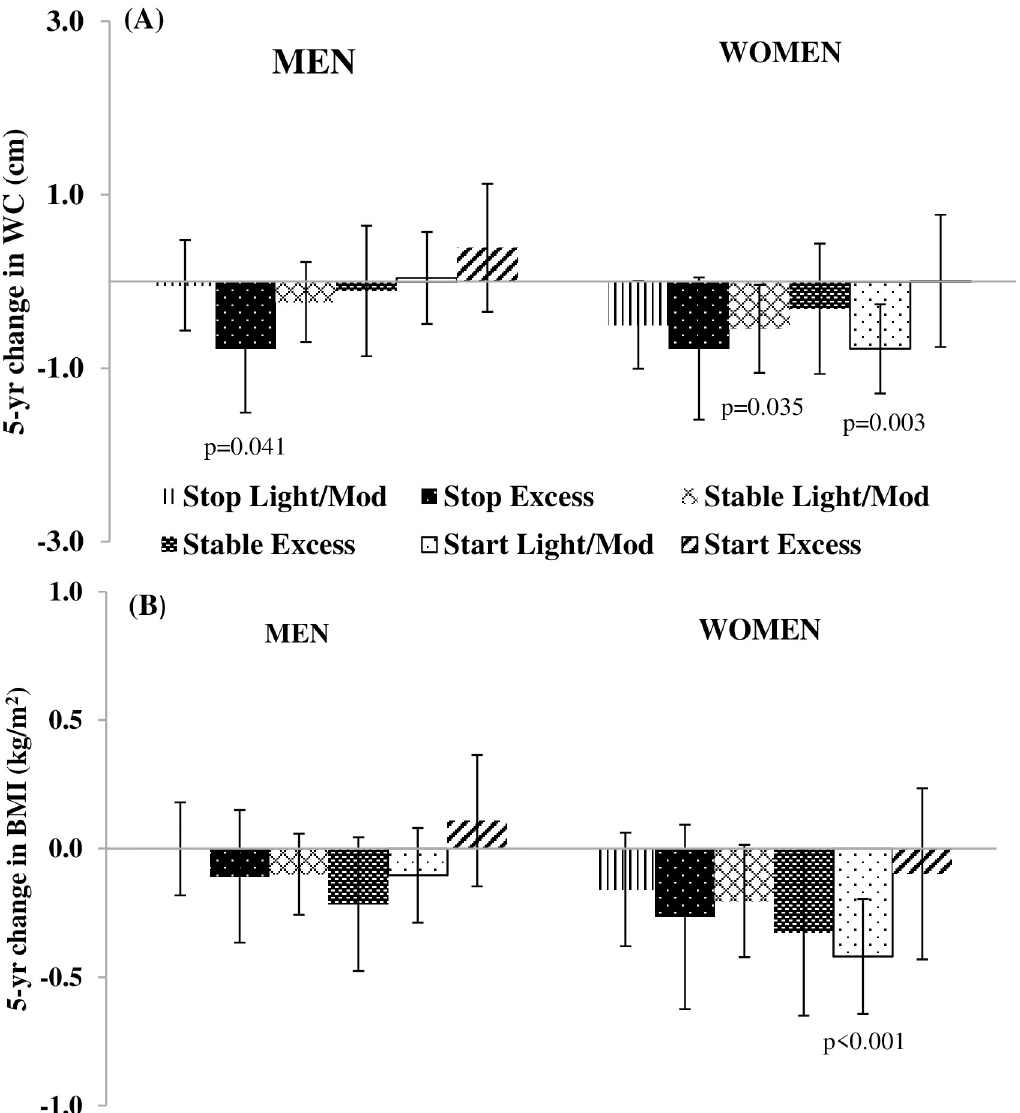
Fig 3. Adjusted associations of 5-yr changes in drinking level with 5-yr changes in (A) Waist Circumference (WC) (cm) and (B) Body Mass Index (BMI) (kg/m 2 ) for men and women in the CARDIA Study from 1985–1986 to 2010–2011. Data from men (N = 1,974) and women (N = 2,381) for 5-yr changes in (A) WC and (B) BMI from CARDIA exam yrs 5, 10, 15, 20 and 25. Values are β coefficients (95% CI) obtained from longitudinal random effects linear regression models adjusted for baseline age cohort membership, baseline WC, race and study center and time-varying income, education, smoking status and time-varying changes in marital status, physical activity and diet quality score. When 5-yr change in BMI was the outcome, models were adjusted for baseline BMI instead of baseline WC. Estimates compared to the referent 5-yr change among “stable non-drinking”. For stable non-drinking men, the adjusted mean 5-yr WC change was +3.77 ± 0.18 cm and the adjusted mean 5-yr BMI change +1.18 ± 0.06 kg/m 2 ; for stable non-drinking women, the adjusted mean 5-yr WC change was +3.78 ± 0.14 cm and the adjusted mean 5-yr BMI change was +1.49 ± 0.06 kg/m 2 . P-values correspond to the 2-tailed p-values used in testing the null hypothesis that β is 0. β estimates having p-values < 0.05 were considered statistically